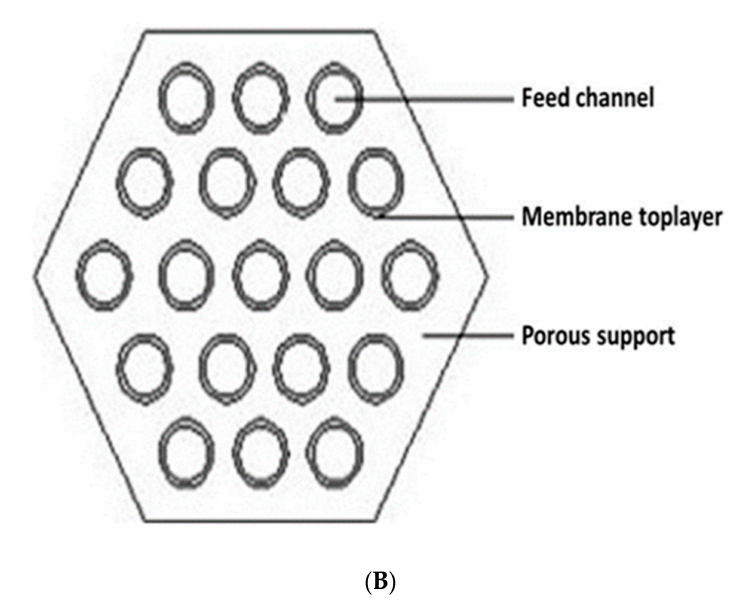
Figure 3. ( A ) Schematic drawing of a tubular module and ( B ) cross-section of monolithic ceramic module [99].